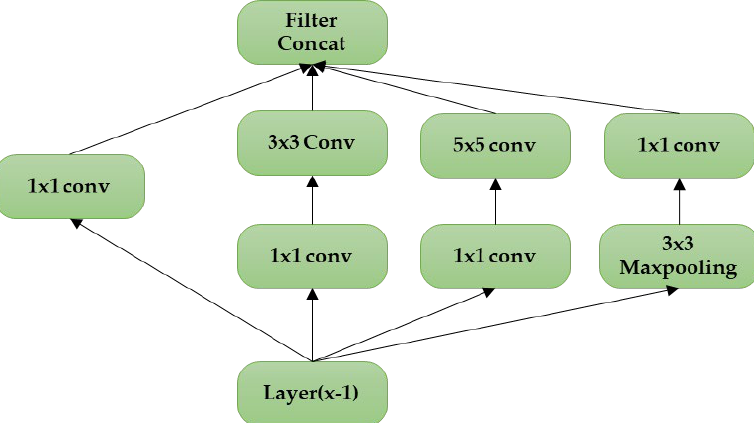
Figure 3. The Inception model modified by adding a MaxPooling layer.